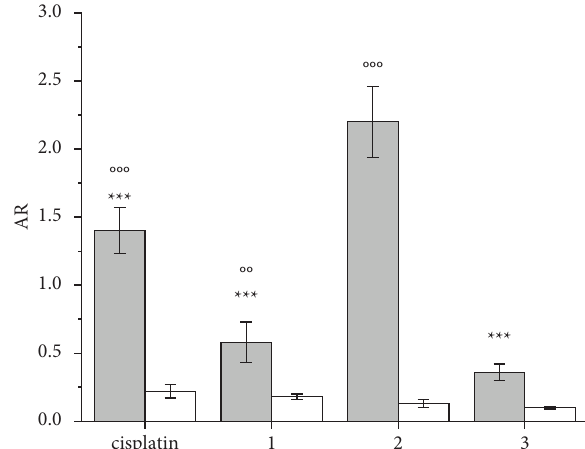
Figure 2: Accumulation ratio (AR) of cisplatin and 1 – 3 complexes in A2780 cells treated for 4h at 37 ° C (gray bars) and 4 ° C (white bars) with 10 μ M concentrations of the compounds. Data are the mean ± sd of three independent replicates and were compared using one-way analysis of variance (ANOVA) with the Tukey post- hoc test. Statistical analysis (cisplatin, 1, and 3 vs. 2, 37 ° C): ∗∗∗ p < 0.001; (37 ° C vs. 4 ° C): °° p < 0.01; °°° p <